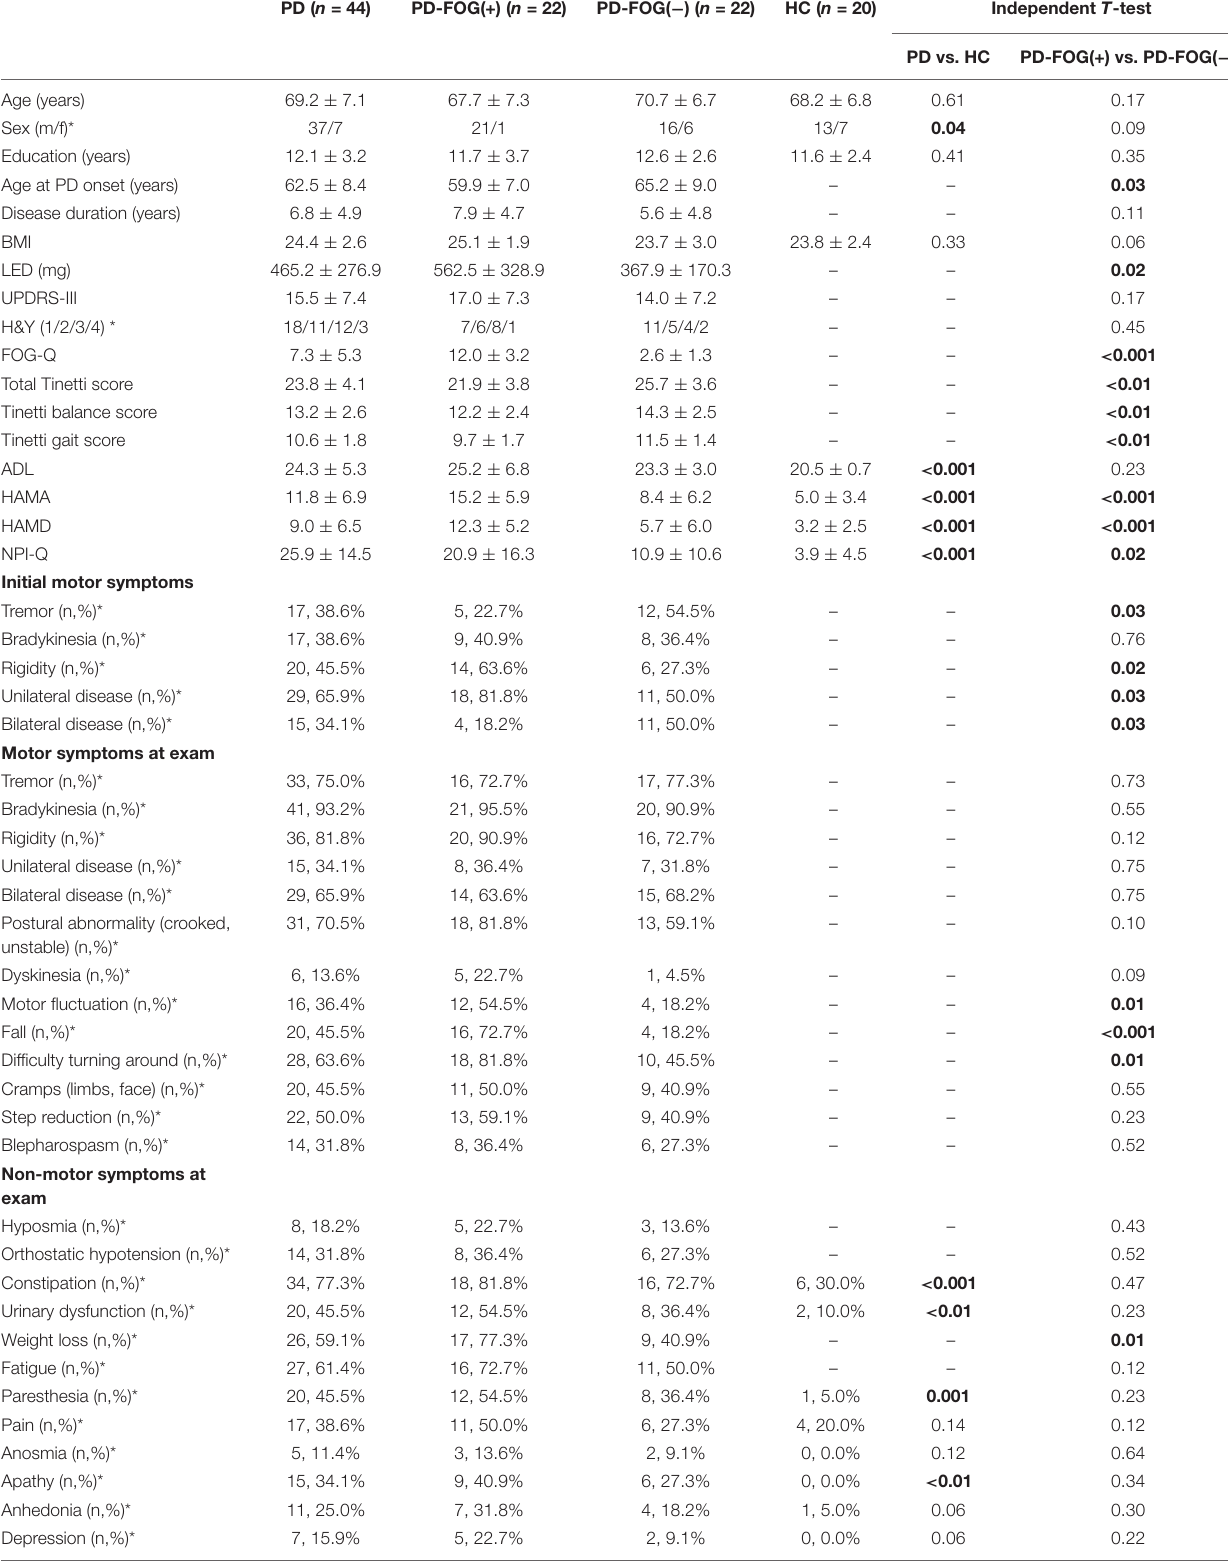
TABLE 1 | Demographical characteristics and clinical symptoms of PD, PD-FOG(+), PD-FOG( − ) patients, and HC. PD ( n = 44) PD-FOG(+) ( n =